Question: Provide a one-line summary of what is displayed.
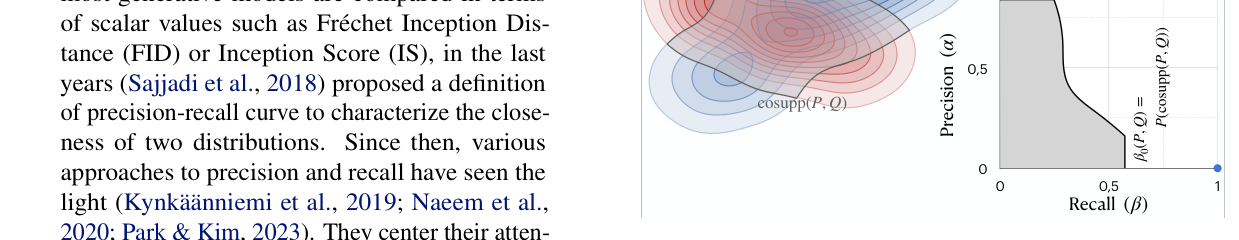
Answer: Right: the PR-curve is the frontier of the shaded area composed of all admissible PR pairs (β, α). In essence, these pairs represent the mass of P and Q that one can recover by selecting a subset of the common support (gray area on the left). More precisely, by selecting regions of high likelihood of P, one trades precision (α) in favor of recall (β). The extreme values β0(P, Q) and α∞(P, Q) embody the respective masses of the entire common support.